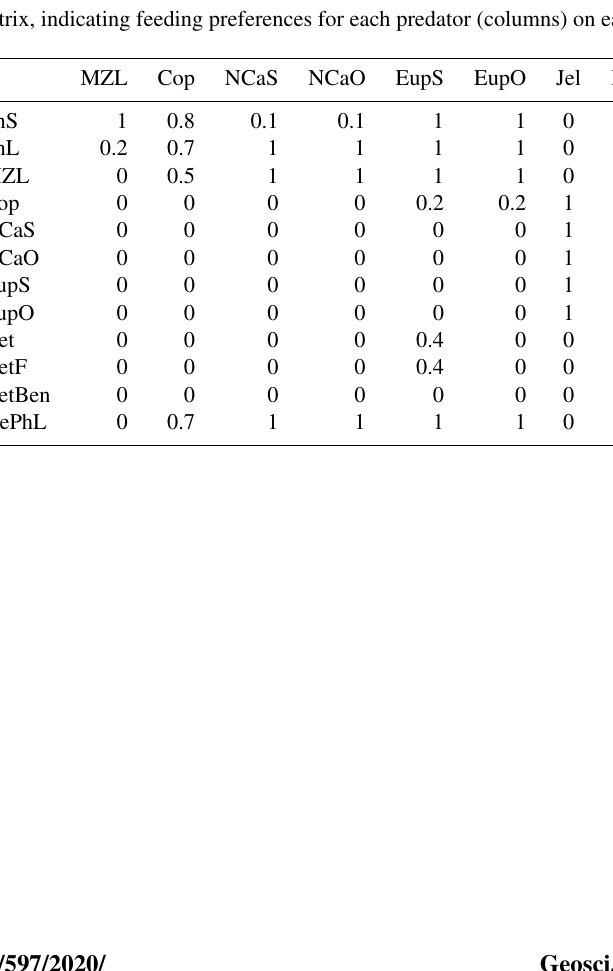
Table A7. Feeding preferences matrix, indicating feeding preferences for each predator (columns) on each prey